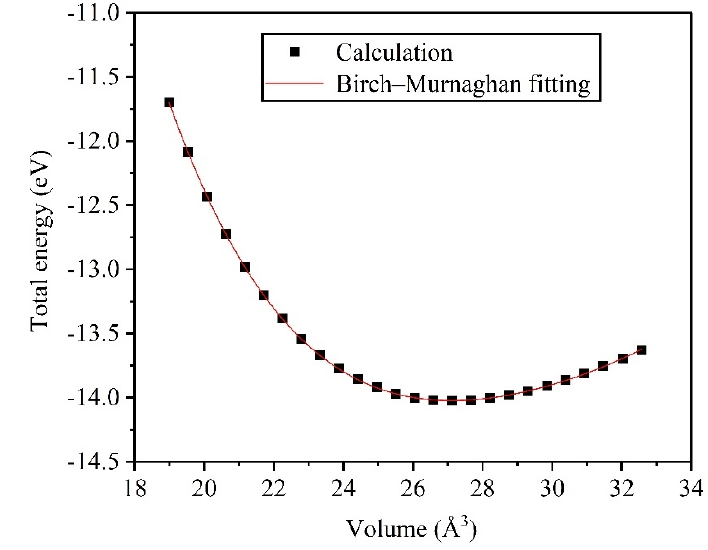
− E V data for the NiTi SMA. Figure 2. The Birch–Murnaghan fitting curve of the E − V data for the NiTi